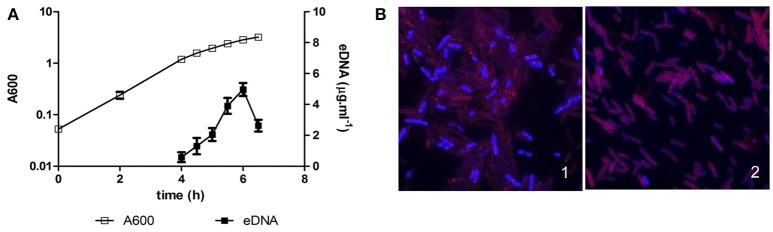
eDNA production in Bacillus subtilis 3610. (A) Batch culture of strain 3610 in MSgg at 37°C with aeration. A600 refers to the absorbance of the culture at 600 nm, and eDNA refers to the concentration of eDNA in the culture supernatant. eDNA is released during the transition from exponential to stationary phase, followed by a rapid decrease in eDNA concentration. The data presented are representative of the results obtained in ten different experiments. (B) fluorescent microscopy image of cells from a wild type 3610 strain (1) and an eDNA defective mutant (2) after 5 h 30 min in batch growth. The DNA is stained blue (DAPI) and cellular membranes are stained red (FM4.64). A subpopulation of cells has a greater intensity of DNA staining in a wild type strain but not in a defective mutant in eDNA production.